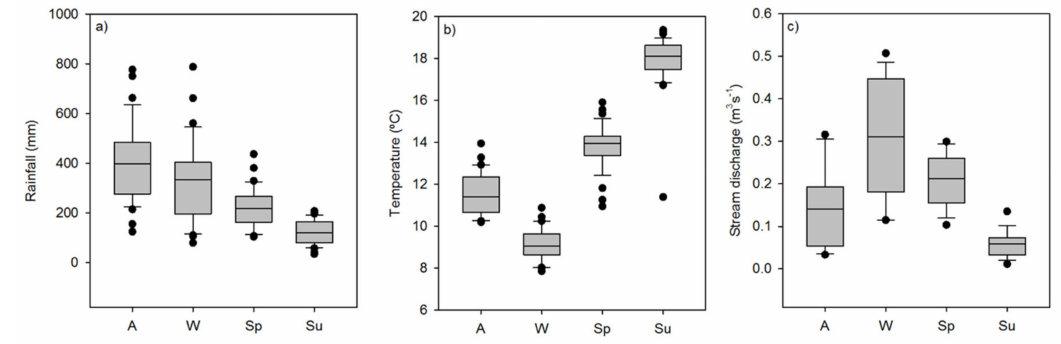
Figure 4. Boxplot of seasonal distribution of ( a ) rainfall, ( b ) temperature and ( c ) discharge in Corbeira